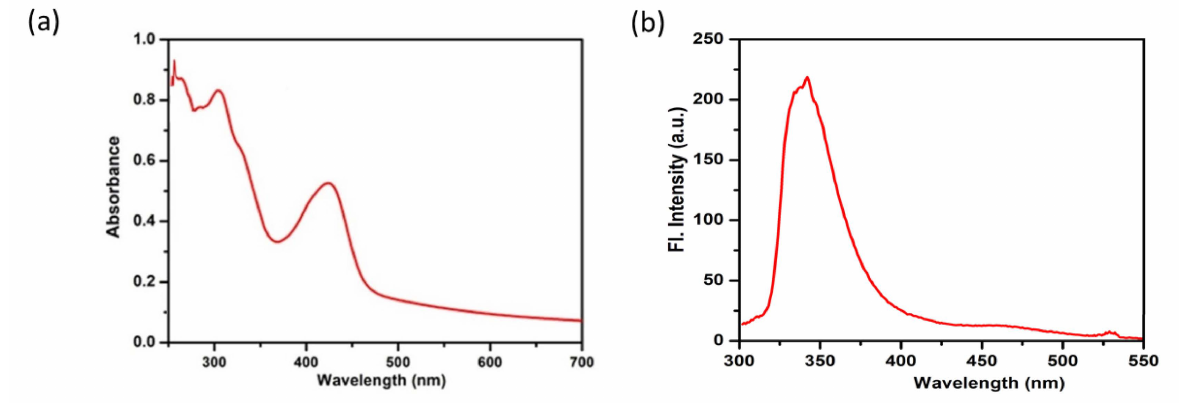
Figure 6. ( a ) UV–Vis absorption and ( b ) luminescence spectra of 1 at room temperature ( λ ex = 300